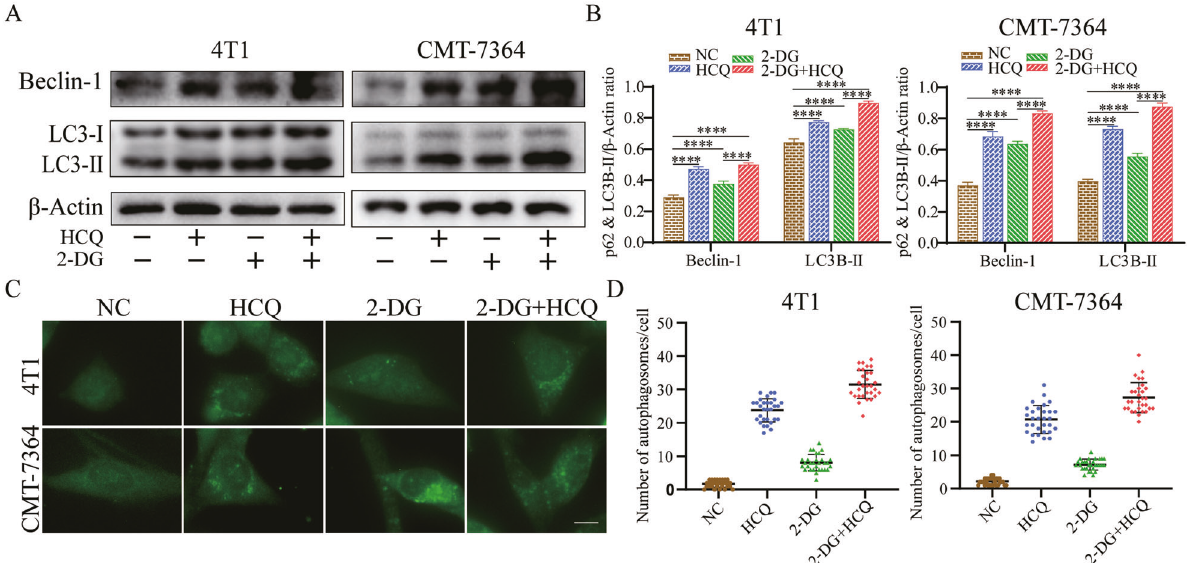
Fig. 5 HCQ combined with 2-DG inhibits autophagic degradation in 4T1 cells and CMT-7364 cells. A , B Western blot analyses of Beclin-1 and LC3B-II in 4T1 and CMT-7364 cells that were treated without or with HCQ, 2-DG or 2-DG combined with HCQ for 24 h. β ‐ actin was used as an internal control. Data are represented as mean ± SD from three independent experiments. ** p < 0.01, **** p < 0.0001. C , D Immuno fl uorescence staining of LC3B-II in 4T1 and CMT-7364 cells, which were treated with HCQ and 2 ‐ DG alone or in combination for 24 h. Scale bar: 10 μ m. n = 3 independent experiments performed in triplicate for each condition and at least 30 cells